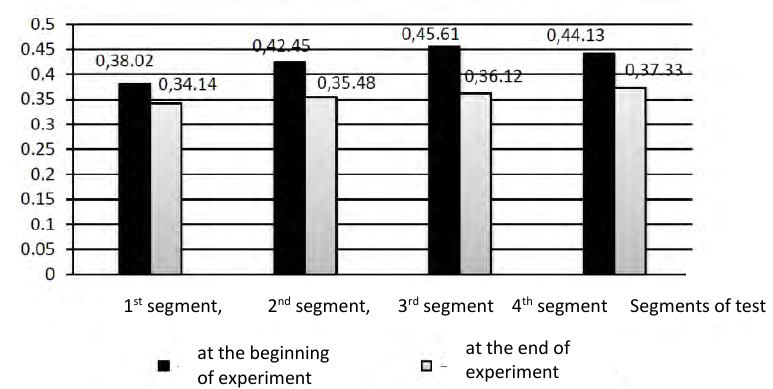
Fig.2. Dynamic of stabilization of results of segments’ swimming in test 4 × 50